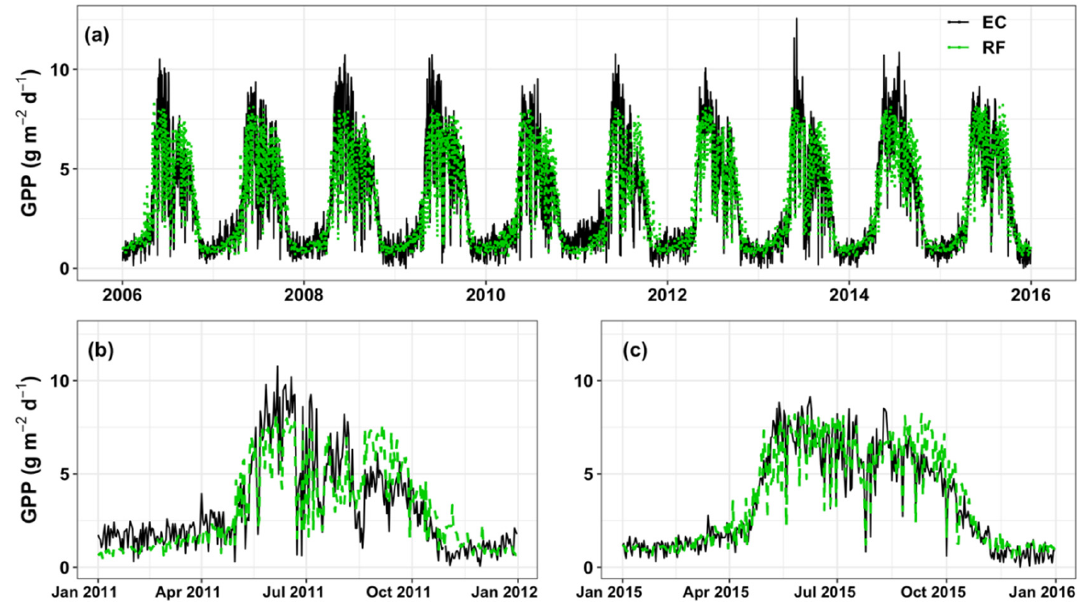
Figure 5. Observed vs. predicted daily gross primary productivity (GPP) by a random forest (RF) model at the Gwangneung site during 2006–2015 ( a ), and the predictions zoomed-in for 2011 ( b ) and 2015 ( c ).